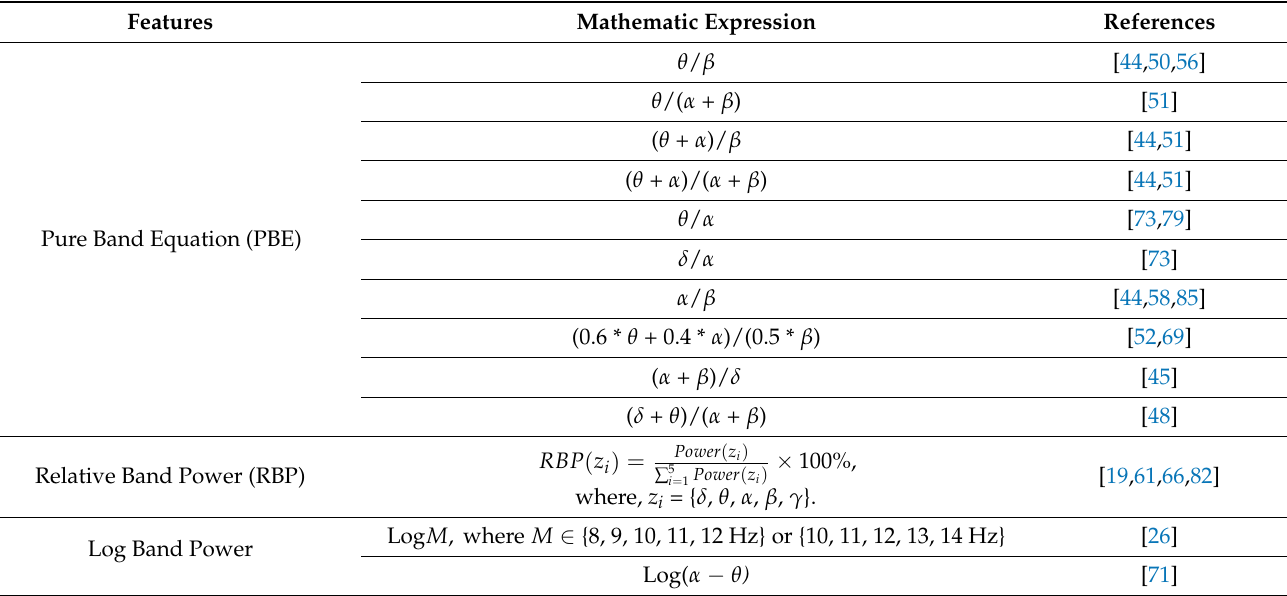
Table 3. The summary of the FFT-based features used in EEG-based